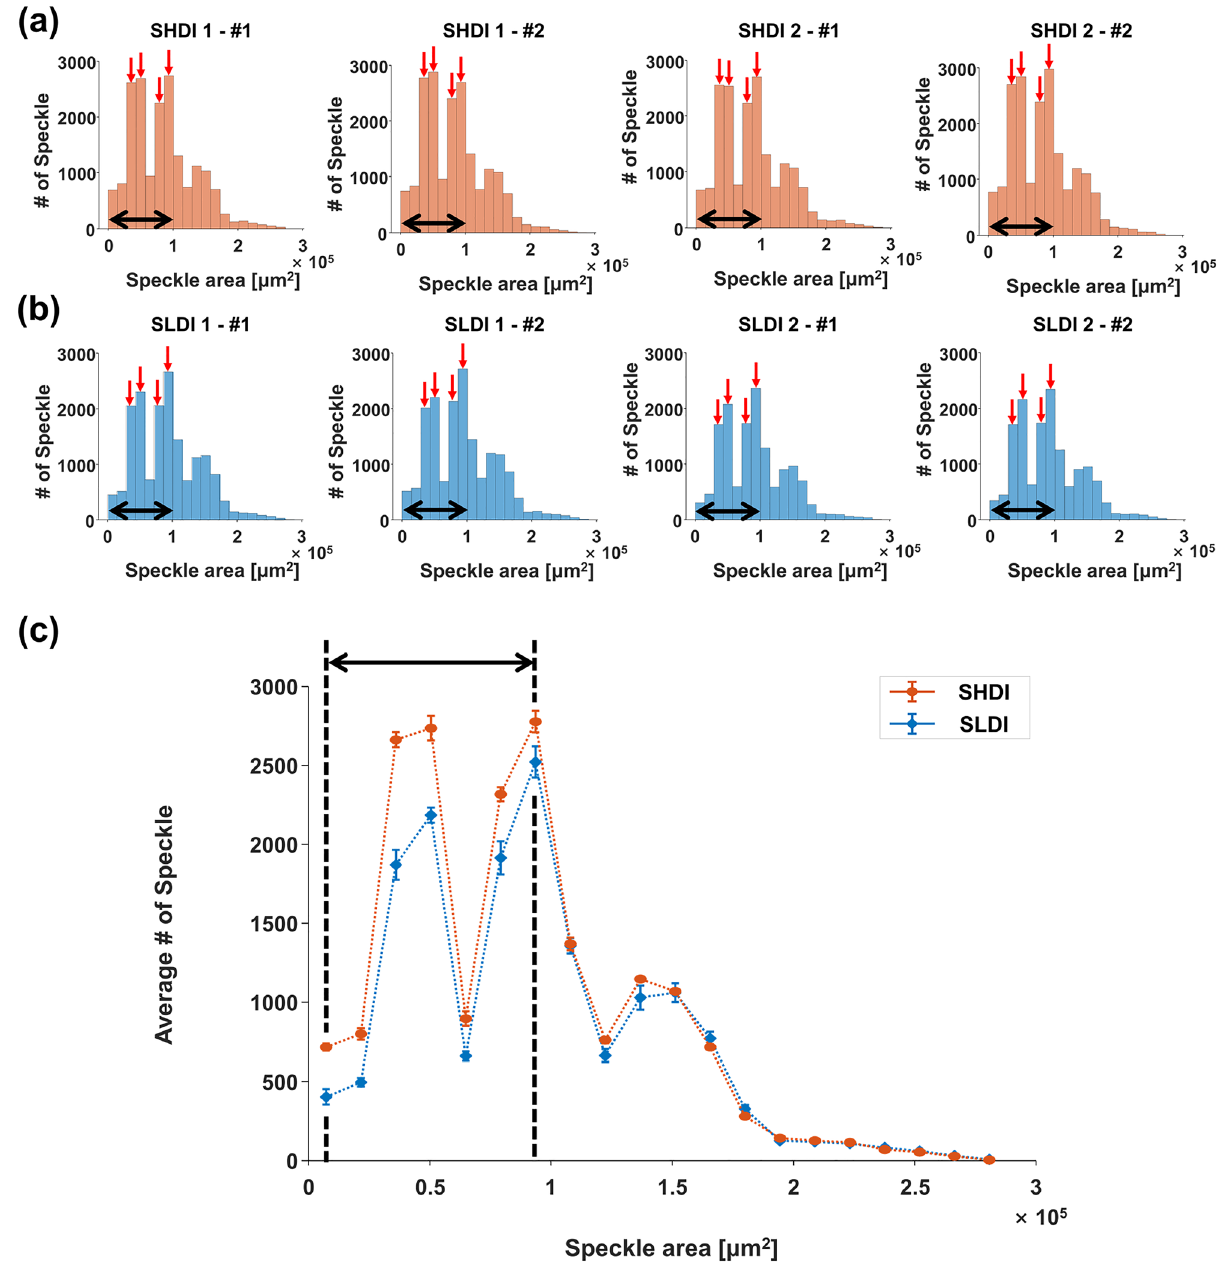
Figure 6. The area histogram results for each region. ( a ) The result of the steel sheets with high-density inclusions (SHDI), and ( b ) low-density inclusions (SLDI). ( c ) Mean values and standard error of the mean (SEM) of the speckle area for the SHDI and SLDI. The implication of red and black arrows is the same as in Fig. 5. (plotted by: MATLAB R2018a—https:// www. mathw orks. com/ produ cts/ matlab.